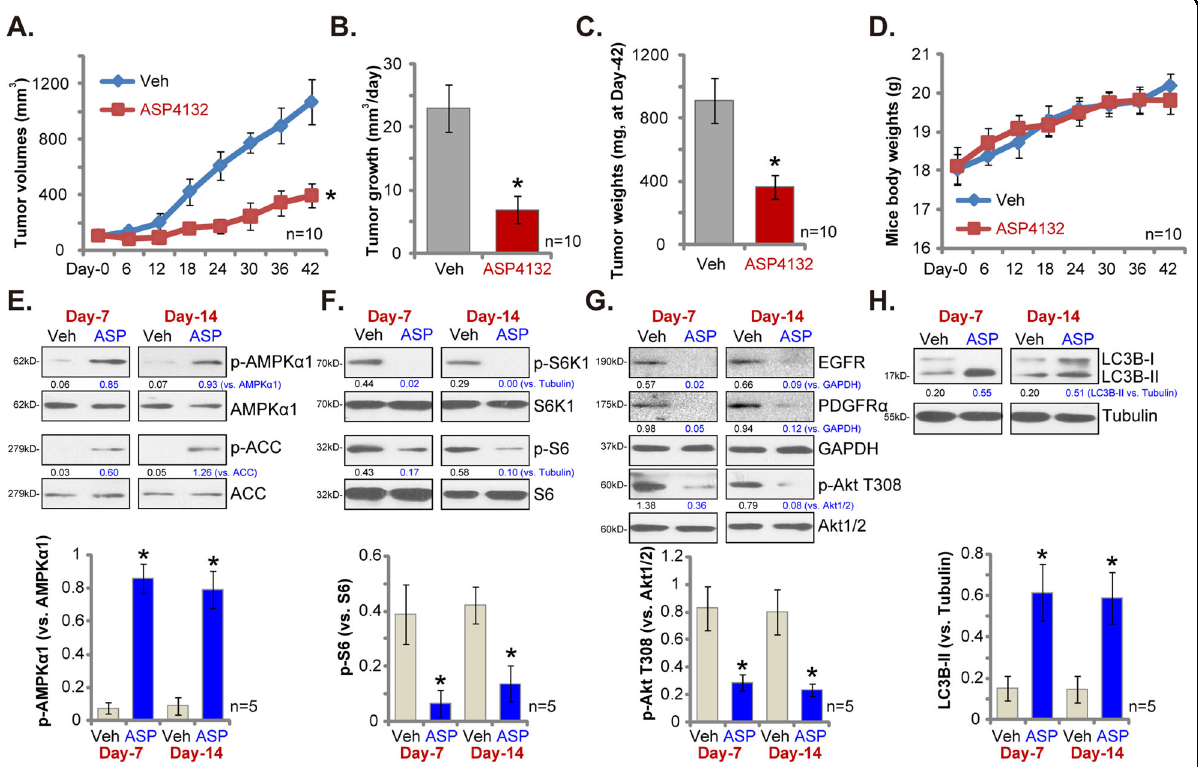
Fig. 6 Oral administration of ASP4132 inhibits NSCLC xenograft growth in SCID mice. The SCID mice-bearing pNSCLC-1 xenograft tumors were treated with ASP4132 (oral administration, 5 mg/kg body weight, daily for 21 days) or vehicle control (ten mice per group/ n = 10); Estimated tumor volumes ( A ) and mice body weights ( D ) were recorded every six days for a total of 42 days; Estimated daily tumor growth was calculated using the described formula ( B ); At the end of experiments, Day-42, tumors of the two groups were separated via surgery and weighted individually ( C ). At experimental Day-7 and Day-14, 4 h after ASP4132/vehicle administration, one tumor of each group was isolated and tumor tissues were subjected to Western blotting assay of listed proteins ( E – H ). Expression of listed proteins was quanti fi ed ( E – H ). Data were presented as mean ± standard deviation